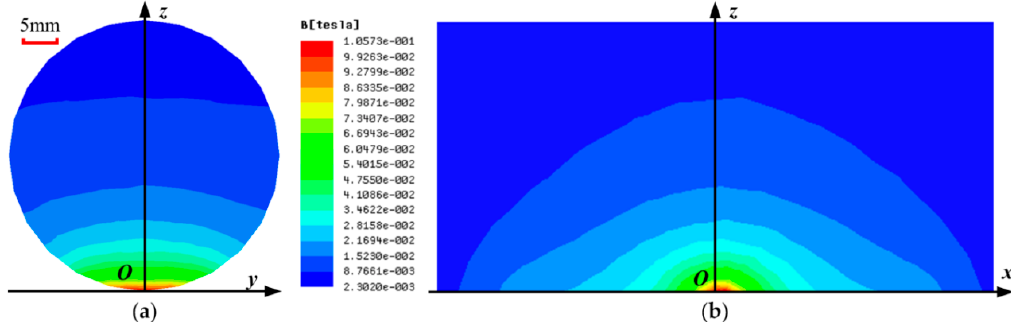
Figure 3. Magnetic distribution in the large-diameter oil tube. ( a ) radial; ( b ) axial.